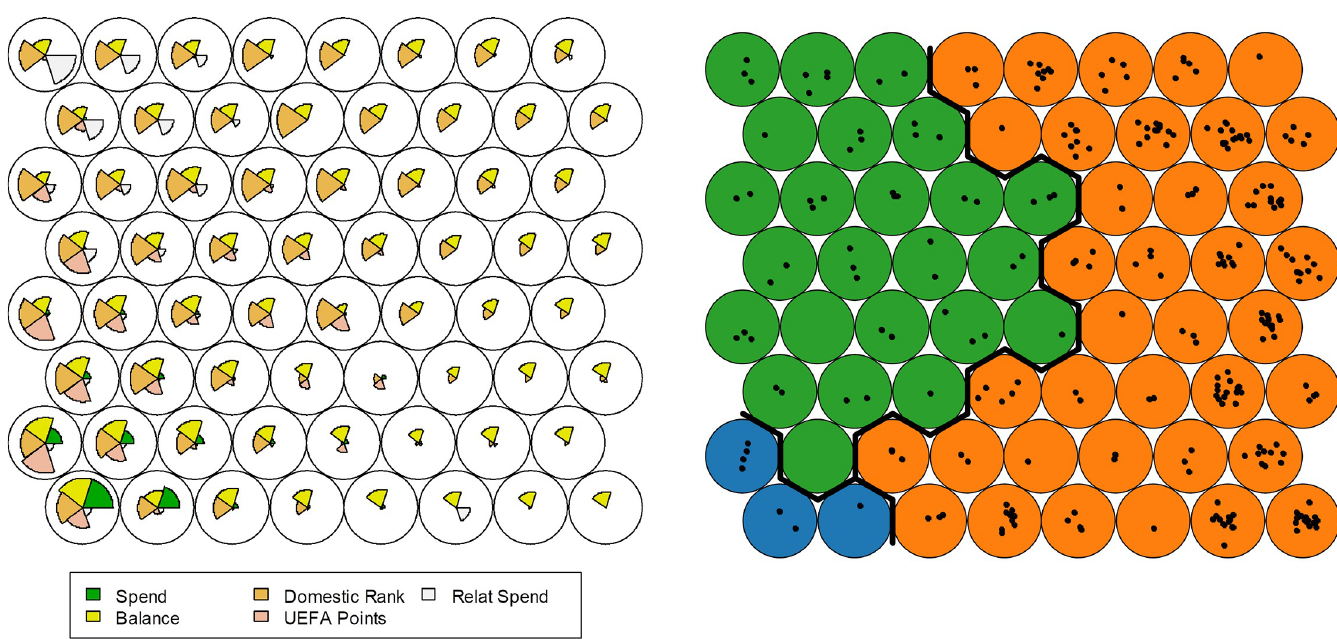
Fig 6. SOM map of codes and clusters for season 2001/2002. The left panel shows the SOM map of codes indicating the underlying distribution of variables involved. The size of each piece of the chart represents the importance of the related variable. The right panel shows the number of clubs belonging to each cell and the optimal number of clusters. This right panel preserves the topological distribution obtained in the left